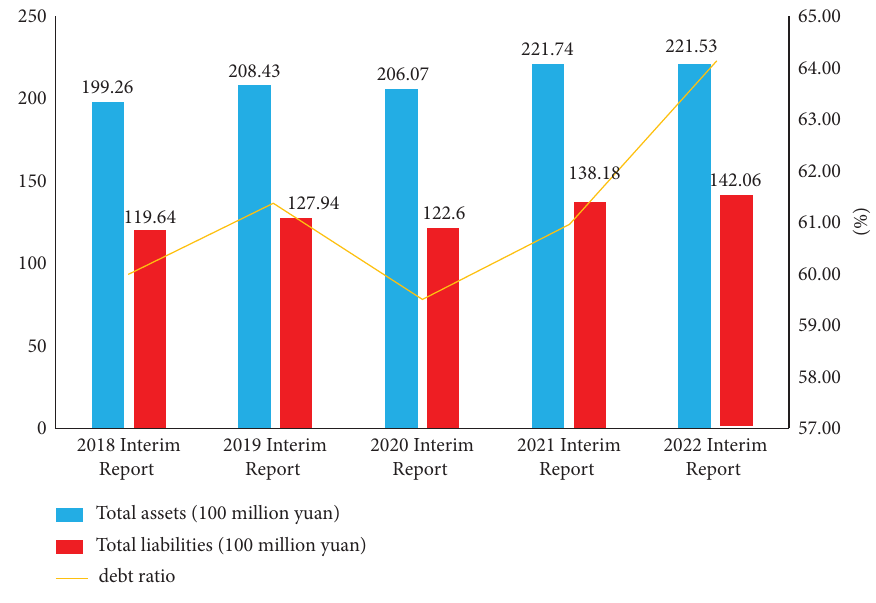
Figure 3: Te asset-liability ratio in 2018–2022.